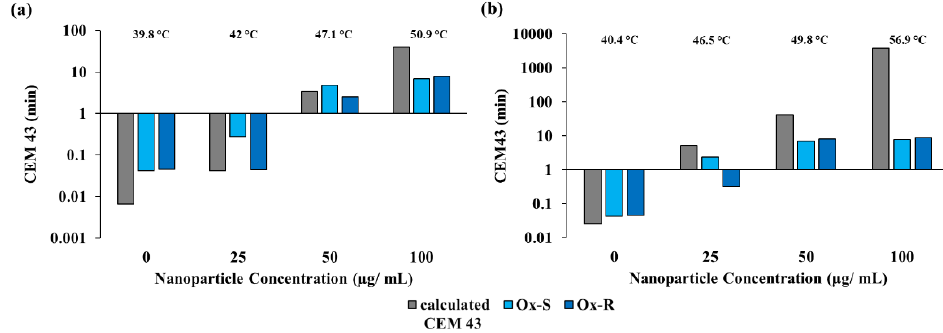
Figure 6. Percent loss of RLU following exposure to increasing VMWNPs concentrations and laser exposure for 60 or 120 s for ( a ) OxS and ( b ) OxR CT-26 cells. * Indicates statistical significance be- tween 60 and 120 s ( p < 0.05).